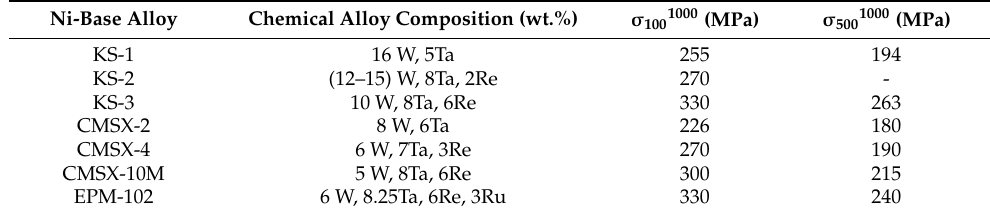
Table 2. The long-term strength of the fully treated KS-(1-3) alloys at the temperature 1000 ◦ C. Ni-Base Alloy Chemical Alloy Composition